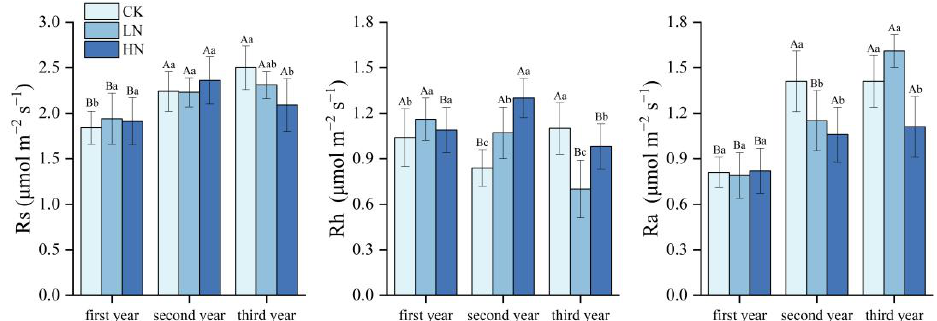
Figure 3. Annual mean values of soil respiration (Rs), autotrophic respiration (Ra), and heterotrophic respiration (Rh) for N application at different rates. Data are presented in terms of mean ± standard deviation values. Different uppercase letters indicate significant differences across years for the same application rate, whereas different lowercase letters indicate significant differences across N application rates in the same year ( p < 0.05). CK, LN, and HN represent control, low, and high nitrogen applications, respectively.